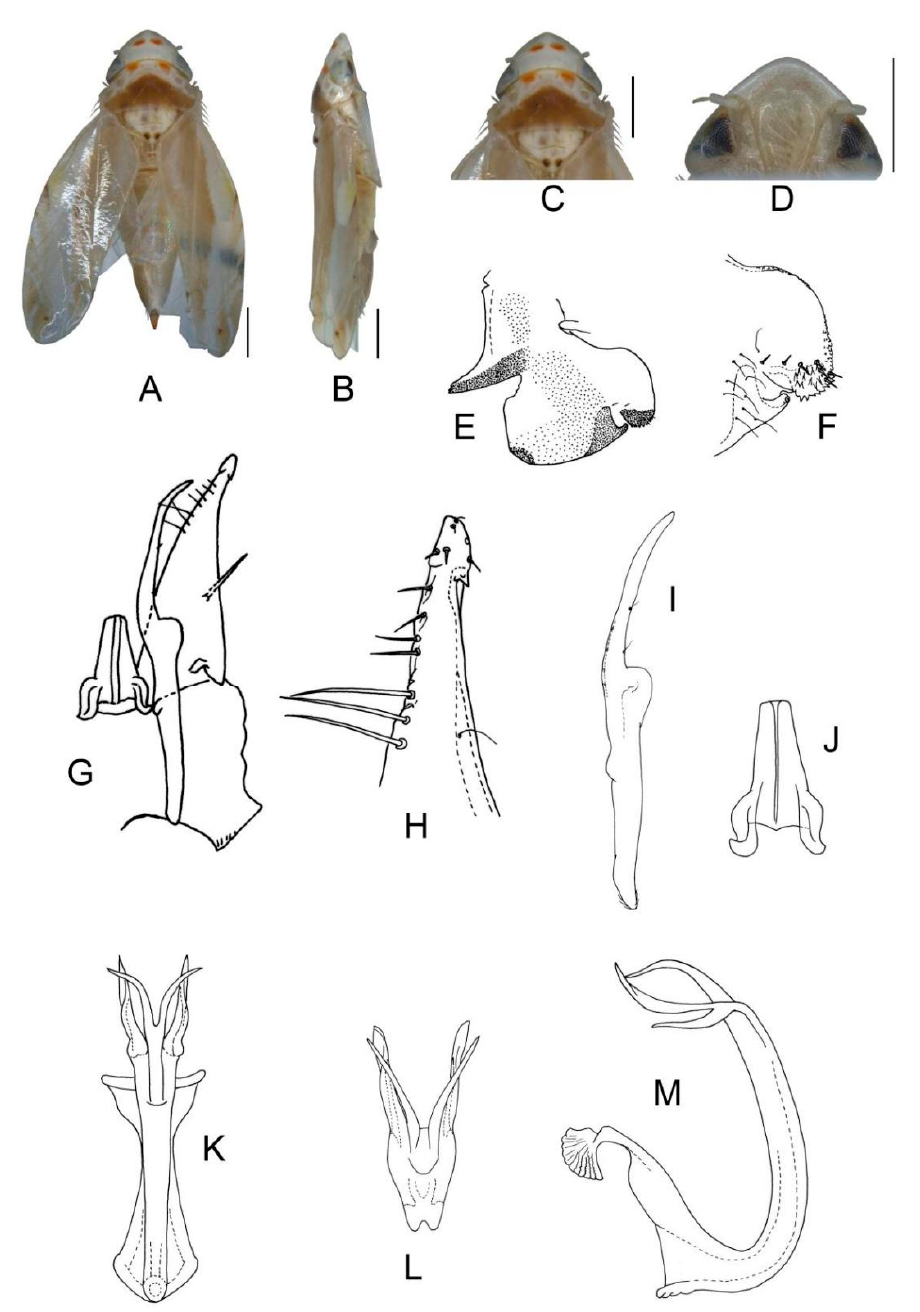
Figure 26. Eurhadina ( Singhardina ) quadrimacularis sp. nov. : ( A ) habitus, dorsal view; ( B ) habitus, lateral view; ( C ) head and thorax, dorsal view; ( D ) face; ( E ) pygofer side, lateral view; ( F ) hind part of pygofer, lateral view; ( G ) subgenital plate, connective, paramere and sternite IX, dorsal view; ( H ) apex of subgenital plate, dorsal view; ( I ) paramere, dorsal view; ( J ) connective, dorsal view; ( K ) aedeagus, posterior view; ( L ) apex of aedeagal shaft, dorsal view; and ( M ) aedeagus, lateral view. Scale bars: 0.5 mm. black preapical spots. Forewing with a longitudinal yellowish-brown streak on corium